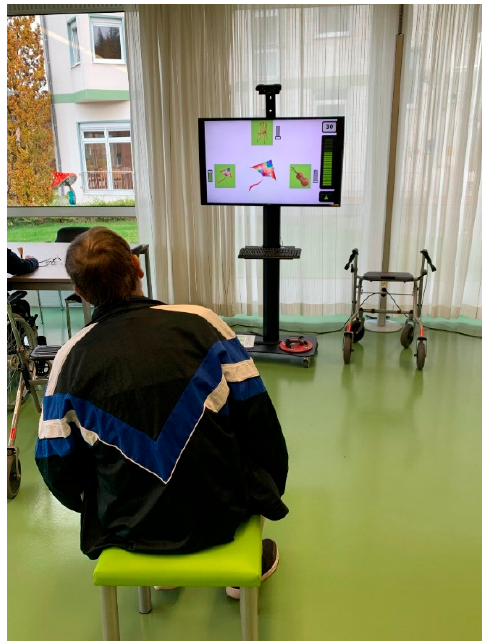
Figure 11. Kinesthetic-visual association exercise at Klinik und Rehabilitationszentrum Lippoldsberg. Patient moves his body, which is motion-tracked, to check that correct answers are “pointed to” through body movement, in this case, matching the kite at center of image to the corresponding kite on the left.